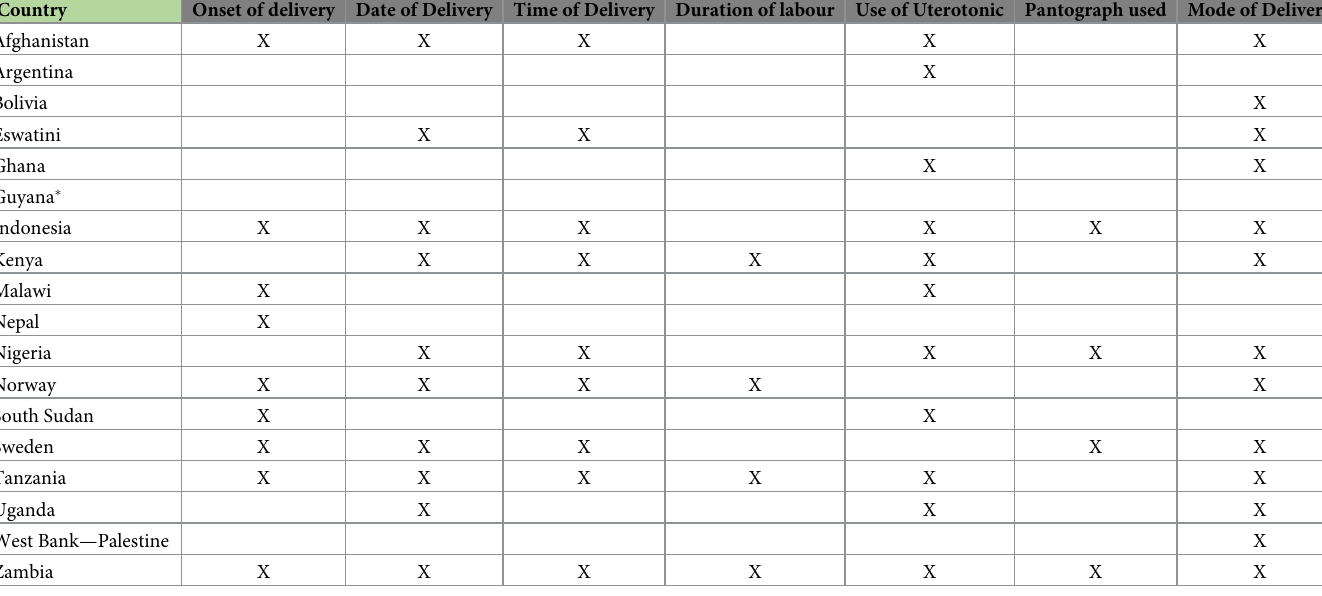
are even less documented; only registers in Kenya and Malawi have these data fields. Similarly, very few countries document HIV testing for the baby, CD4 cell count and viral load Table 5. Childbirth information.